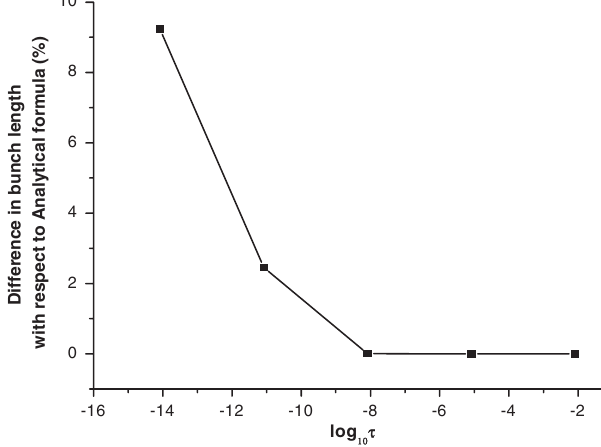
FIG. 5. Variation in difference in final bunch length obtained from analytical expression and MAD as a function of initial bunch